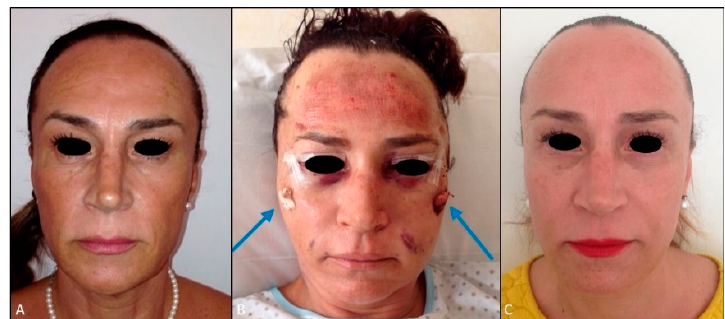
Figure 5. Pre-operative ( A ), immediate postoperative ( B ), and two-year follow-up ( C ) results of a 52-year-old transgender patient having malar implants insertion. During the same operating time, facelift, breast augmentation, upper and lower blepharoplasty, canthopexy, and CO2 forehead treatments were also performed. In (B) blue arrows point to the anchoring suture used to insert and fix the implants.